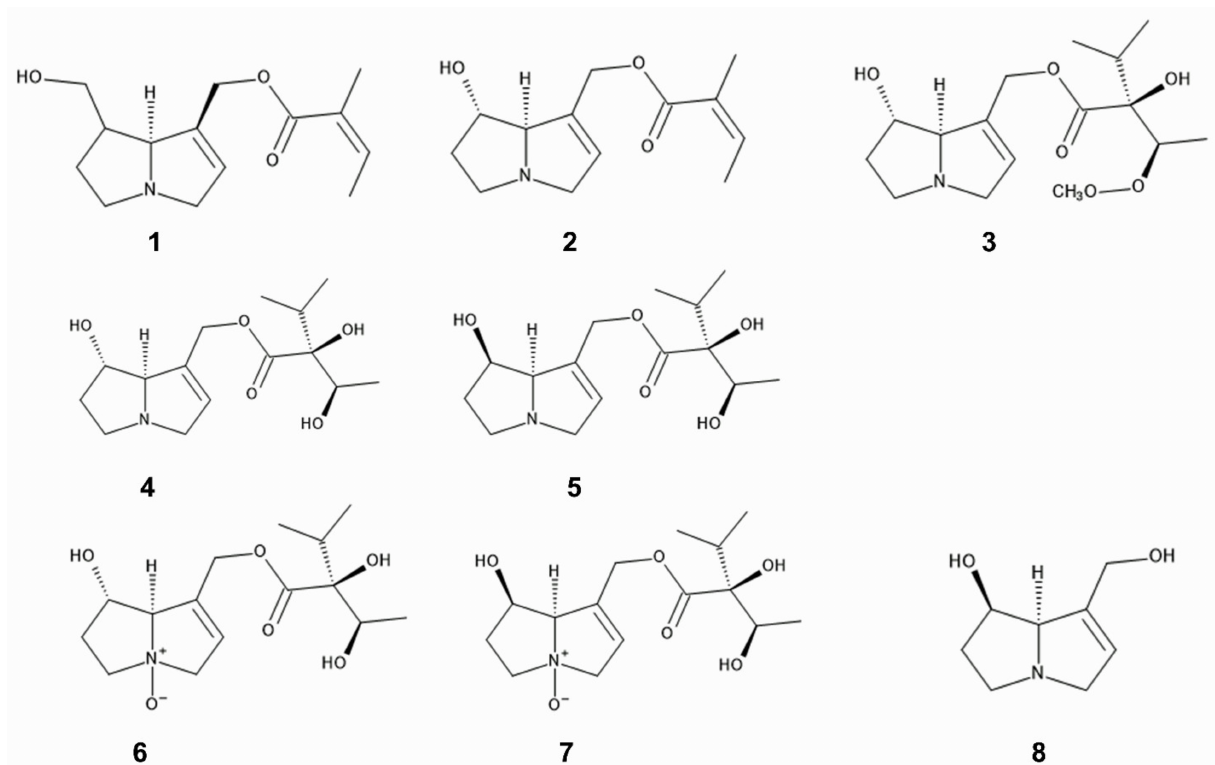
Figure 2. Pyrrolizidine alkaloids; 1: 7-angeloylretronecine, 2: 9-angeloylretronecine, 3: 3 (cid:48) -acetylrinderine, 4; rinderine, 5: intermedine, 6: rinderine N -oxide, 7: intermedine N -oxide, 8: 1,2-dehydropyrrolizine